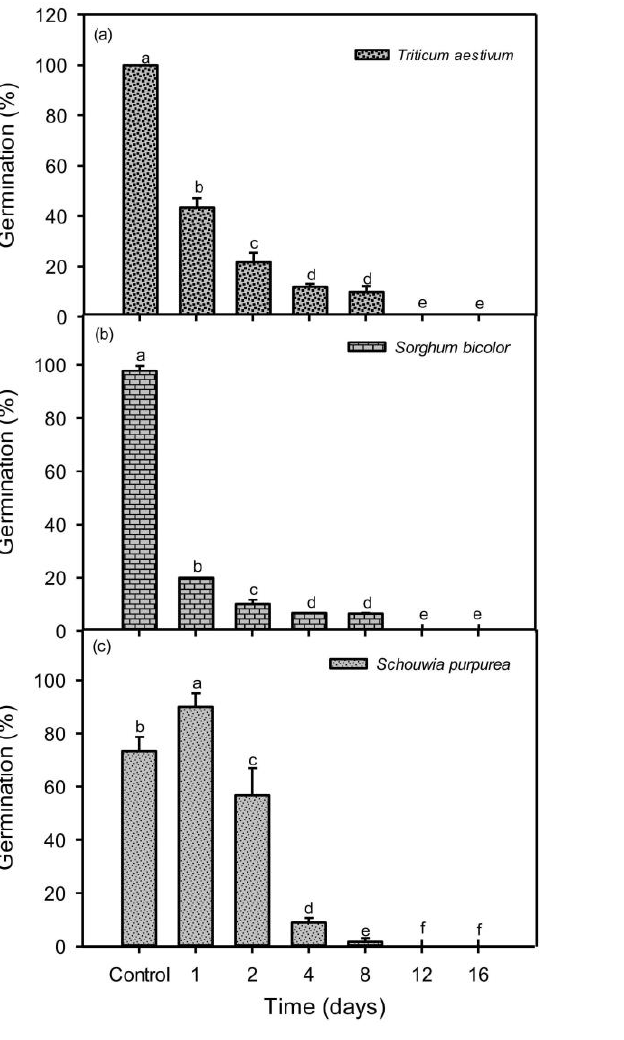
Figure 2. Percentage of the seeds of the six weed species that germinated, across six anaerobic digestion incubation time periods (1, 2, 4, 8, 12, and 16 days). The six panels present the data for each of the study species: ( a ) Triticum aestivum , ( b ) Sorghum bicolor , ( c ) Schouwia purpurea , ( d ) Polygonum equisetiforme , ( e ) Amaranthus viridis , and ( f ) Lotus arabicus . Different letters at the top of the histograms indicate percent germination values that are significantly different ( p < 0.05).